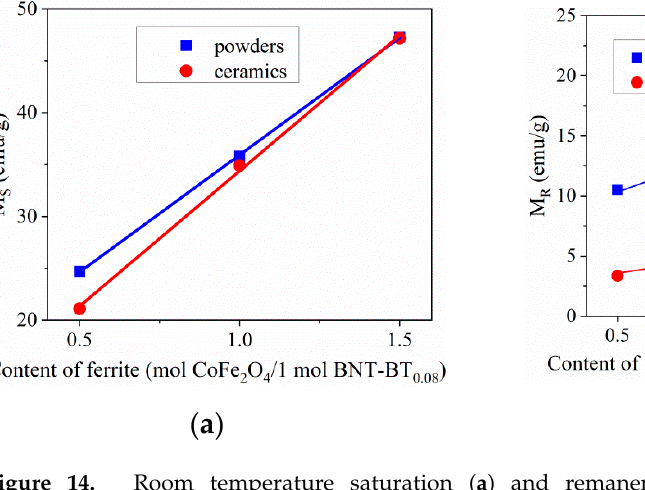
Figure 14. Room temperature saturation ( a ) and remanent ( b ) magnetization values of BNT–BT 0.08 /CoFe 2 O 4 core–shell powders and ceramics vs. content of CoFe 2 O 4 (the lines connecting the experimental data are linear fittings).